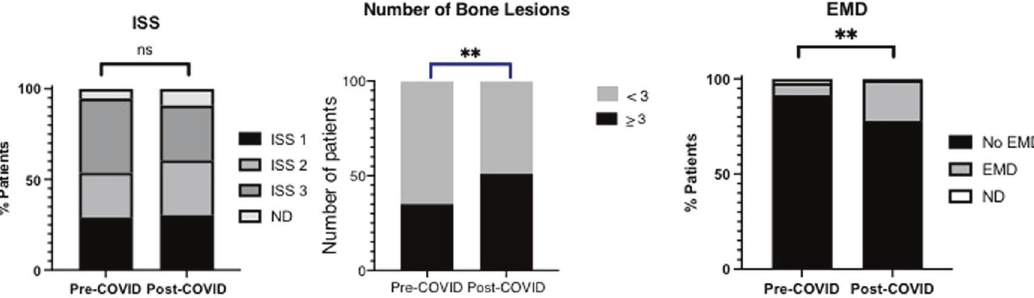
Fig. 2 Presenting disease burden of newly diagnosed myeloma patients, those diagnosed from 1st January 2019 – 31st January 2020 (Pre-C, n = 110) and those diagnosed from 1st February 2020 – 31st July 2021 (Post-C, n = 213). * p < 0.05, ** p < 0.01, ns Not Signi fi cant, ISS International Staging System, MBD myeloma bone disease (>3 lytic lesions) EMD extra-medullary